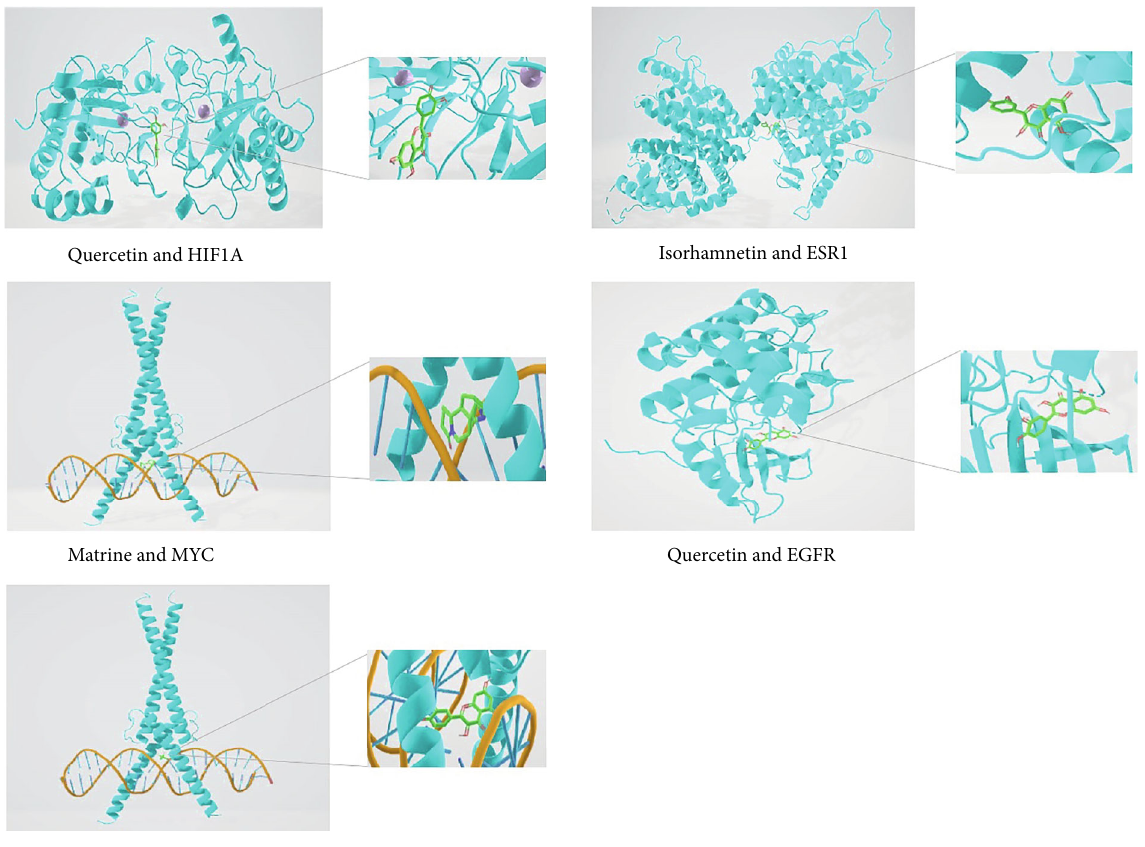
Figure 6: Molecular docking analysis of quercetin and HIF1A, matrine and MYC, quercetin and MYC, isorhamnetin and ESR1, and quercetin and